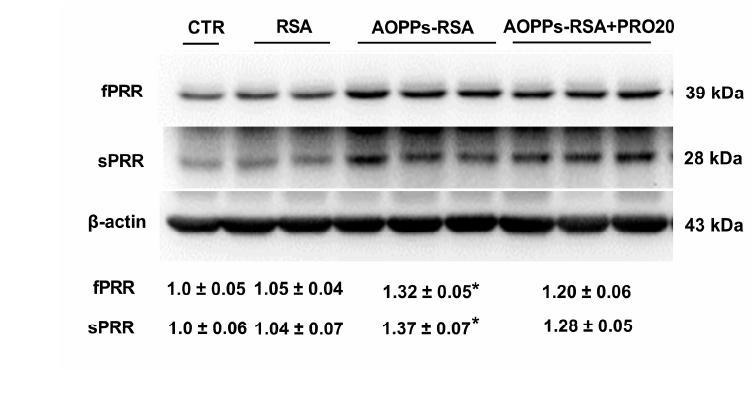
Figure 4. Administration of PRO20 reduced renal oxidative stresses induced by AOPP-RSA. Notes: ( A ) Urinary TBARS concentration; ( B ) renal cortex TBARS concentration; ( C ) renal cortex GSHPx activity; ( D ) urinary H 2 O 2 content; ( E ) renal cortex H 2 O 2 content; ( F ) mRNA levels of Nox4 were determined by RT-qPCR. All values were normalized against GAPDH expressions; ( G ) protein ex-